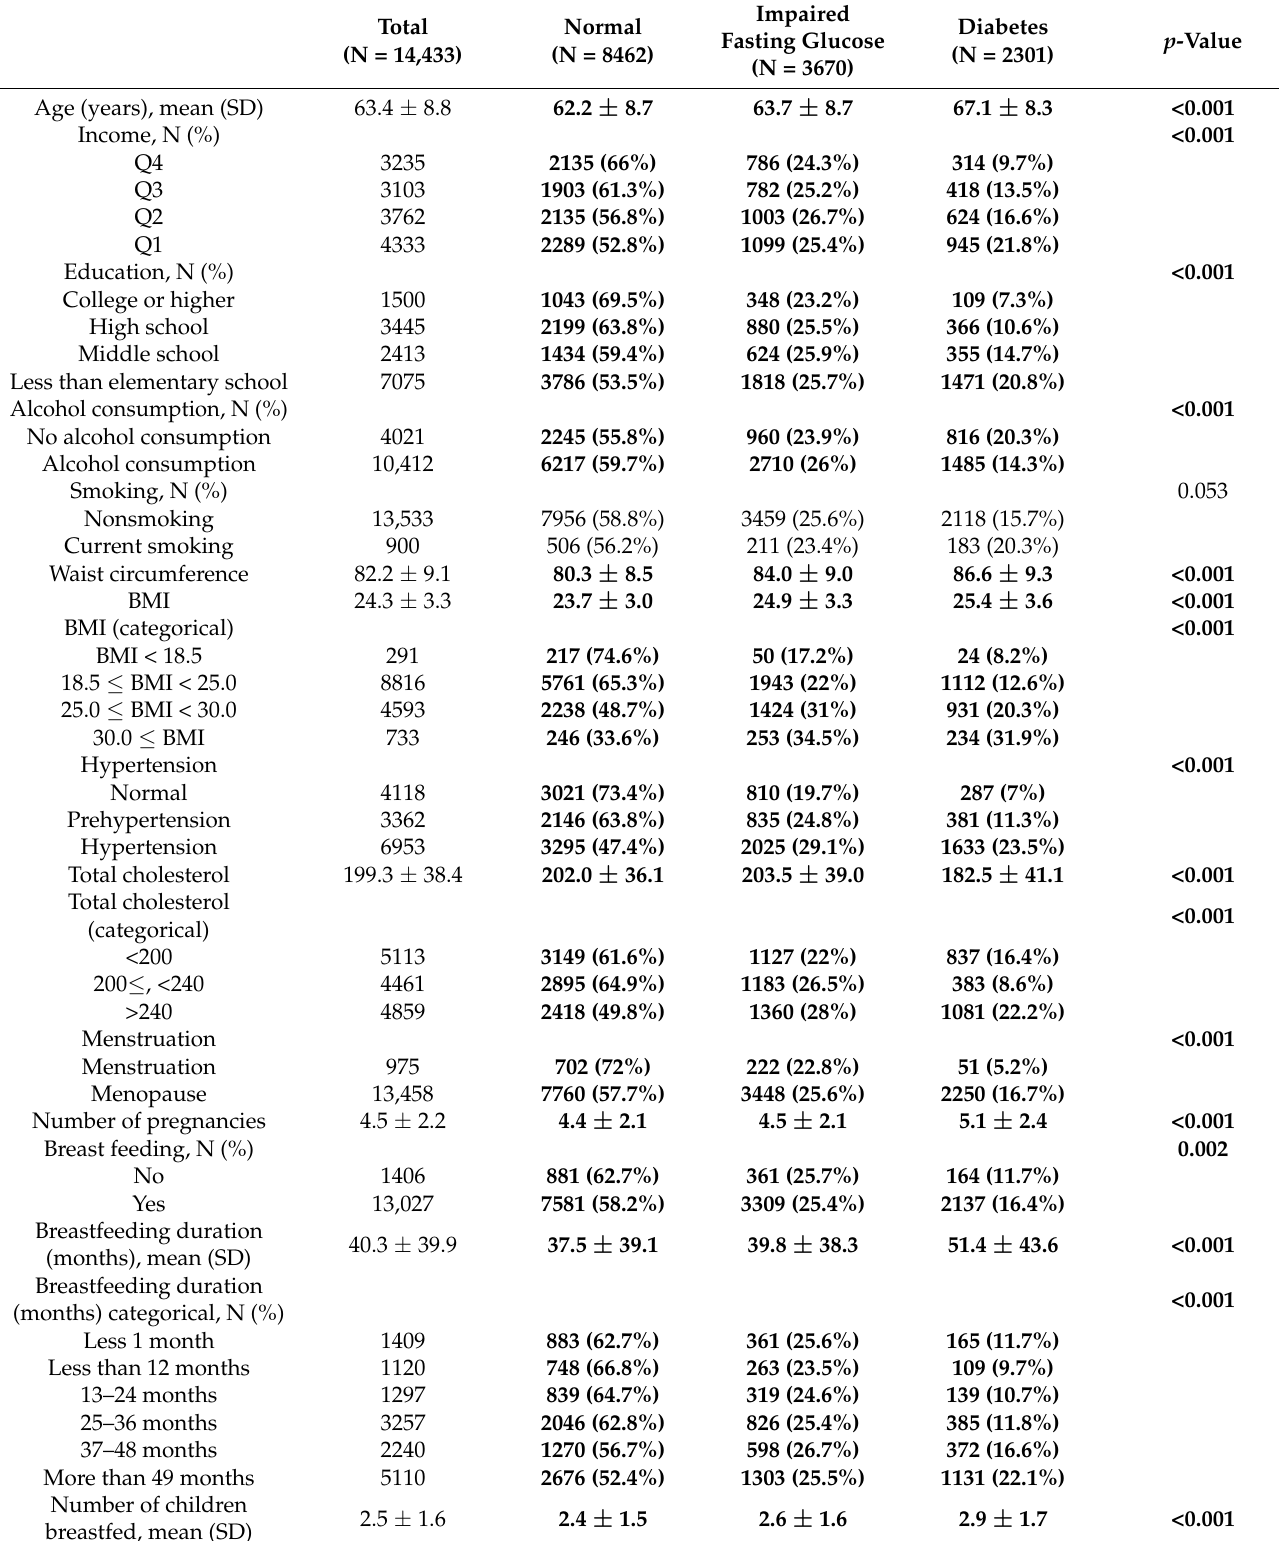
Table 1. Characteristics of the study participants by glucose